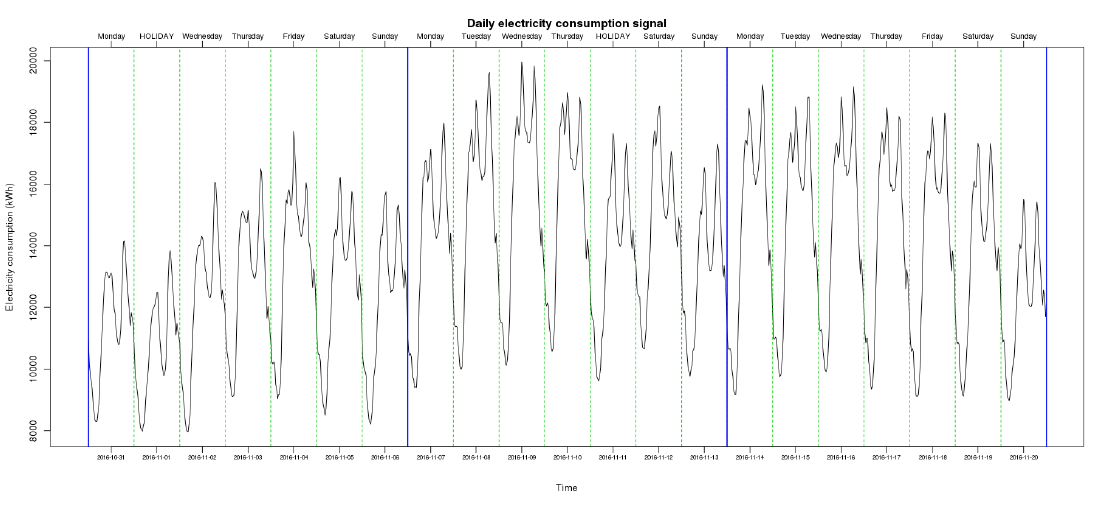
Figure 5. Electricity consumption from 31 October 2016 to 20 November 2016.